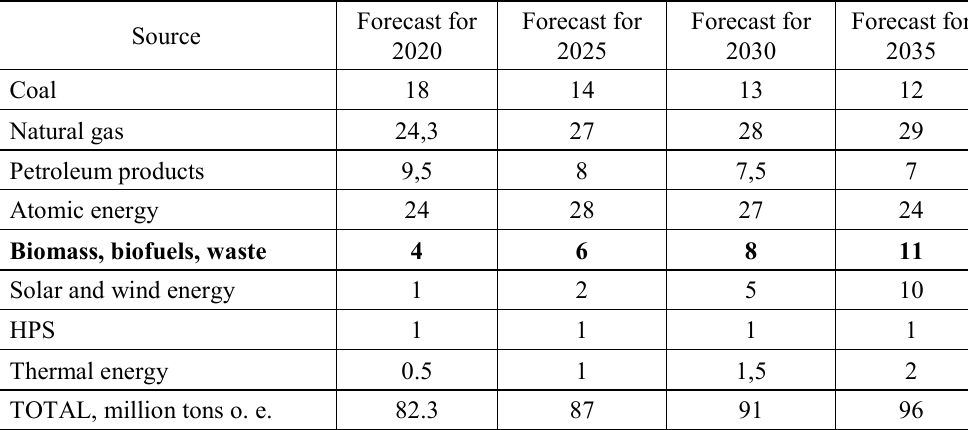
Table 3. Bioenergy Potential of Ukraine, million tons o.